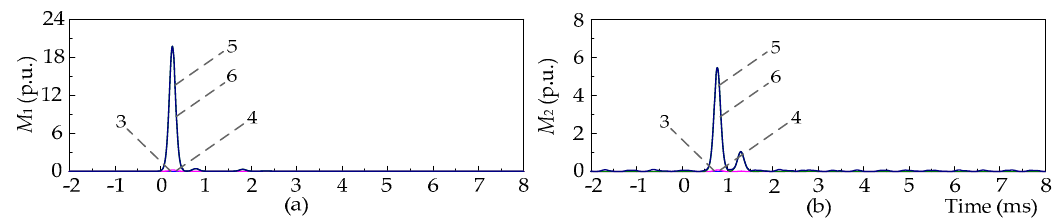
Figure 14. The curves of M 1 and M 2 extracted from different mode currents during the PG fault 50 km from the rectifier-terminal with a fault resistance of 100 Ω . ( a ) Curves of M 1 . ( b ) Curves of M 2 .